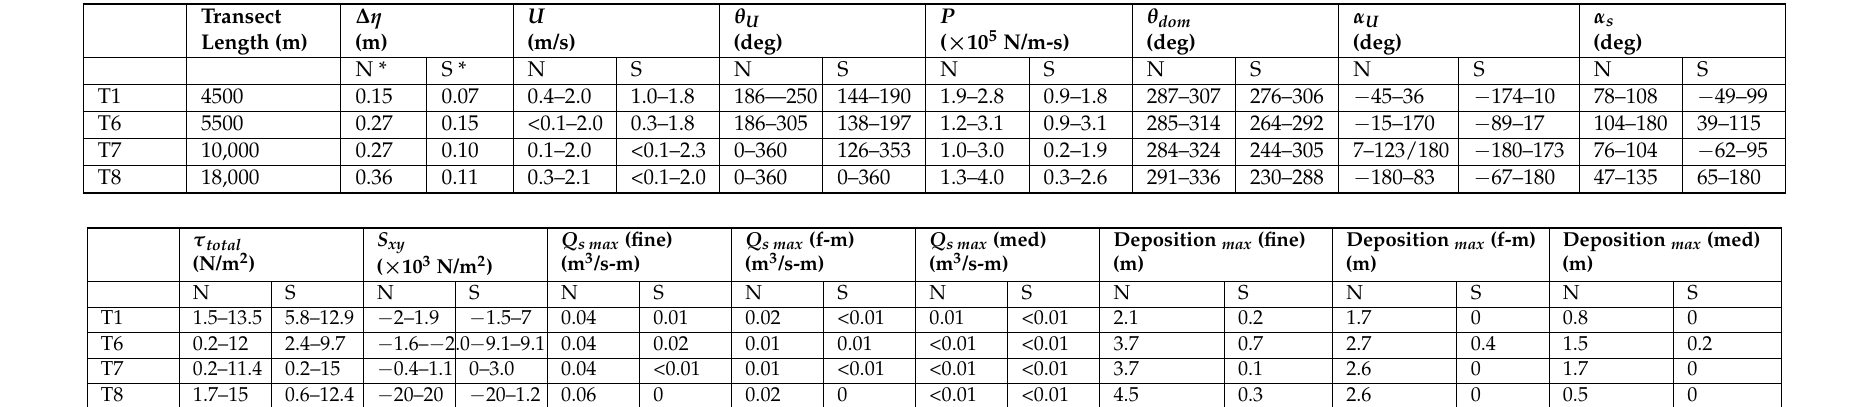
Table 10. Alongshore transect results for forcings and sediment